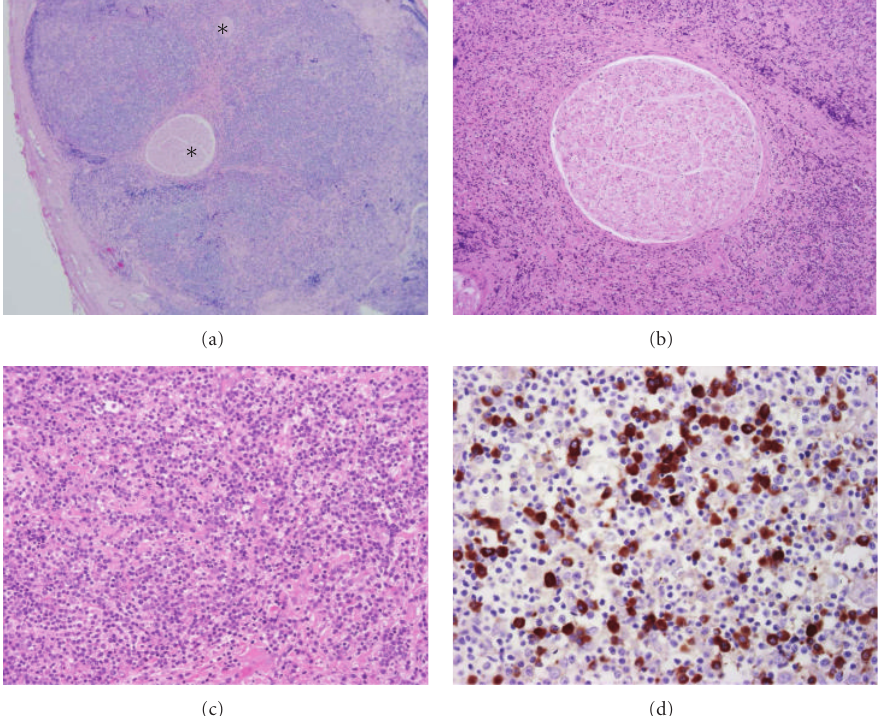
Figure 5: Histological features of resected IgG4-related perineural disease in 61-year-old man (case 7). (a) The epineurium is involved in a massive inflammatory process, where nerve fascicles ( ∗ ) are embedded. (b) The endoneurium is unremarkable without inflammatory cell infiltration. (c) Inflammatory cells consist predominantly of lymphocytes and plasma cells. (d) Immunostaining for IgG4 reveals a large number of IgG4+ plasma